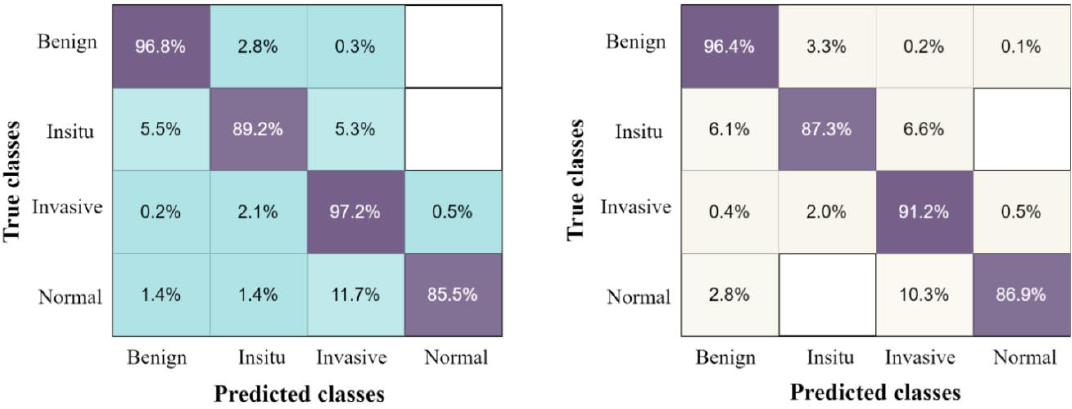
Figure 6. The confusion matrix results of the proposed method on breast cancer pathology dataset, with ESD classifier using the ten-fold method on the left, and five-fold method on the right. The accuracy comparison of the proposed fusion-based method of four-class classifi- cation with existing work is presented in Table S3, which shows that the proposed method achieves the highest accuracy of 94.20% in four-class breast cancer classification.